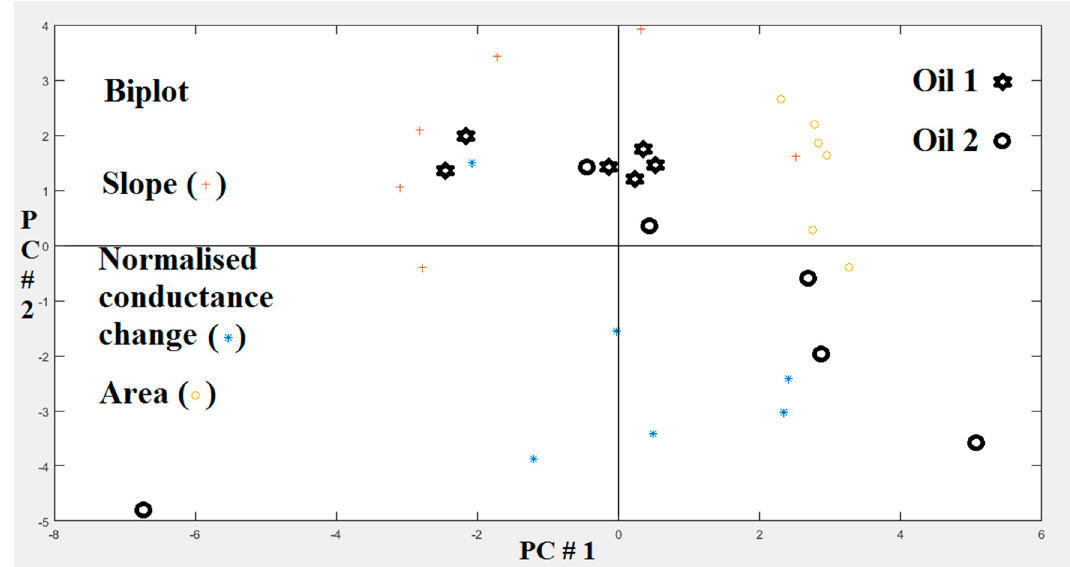
Figure 8. PCA biplot displaying samples of essential oils using conductance change (Delta-G), slope, and area.